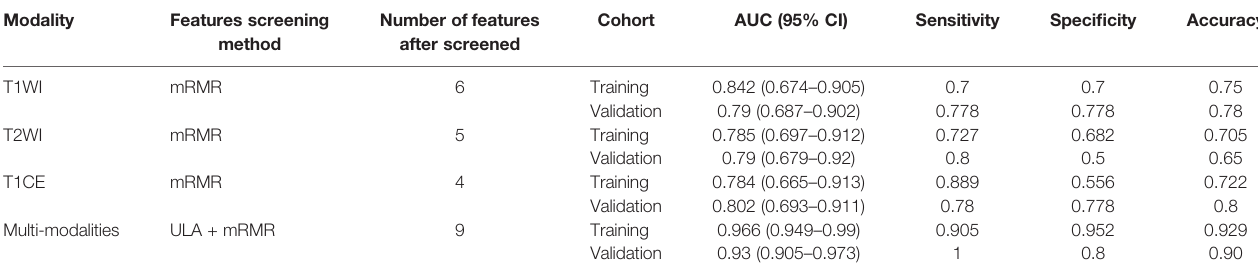
TABLE 4 | The performance of the models for predicting tumor recurrence in the training and validation